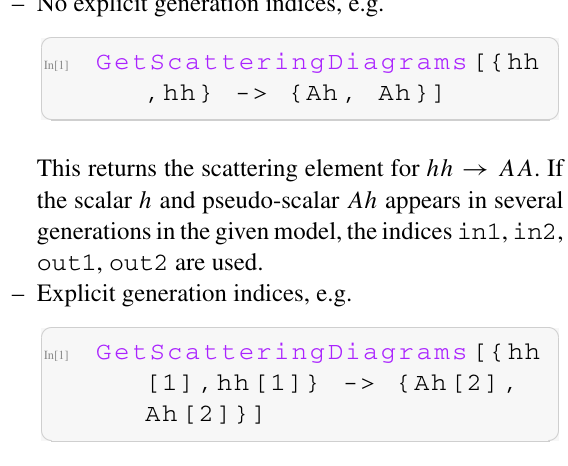
are included in the SPheno output. Below, we give some details how to work with both